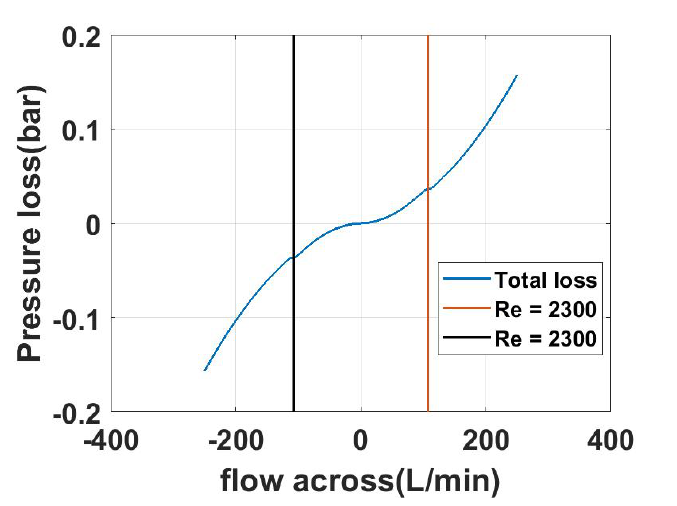
Figure 9. The pressure loss of the hose which has a 1-m length and 3.81 × 10 − 2 m diameter with different flow rates across the hose.